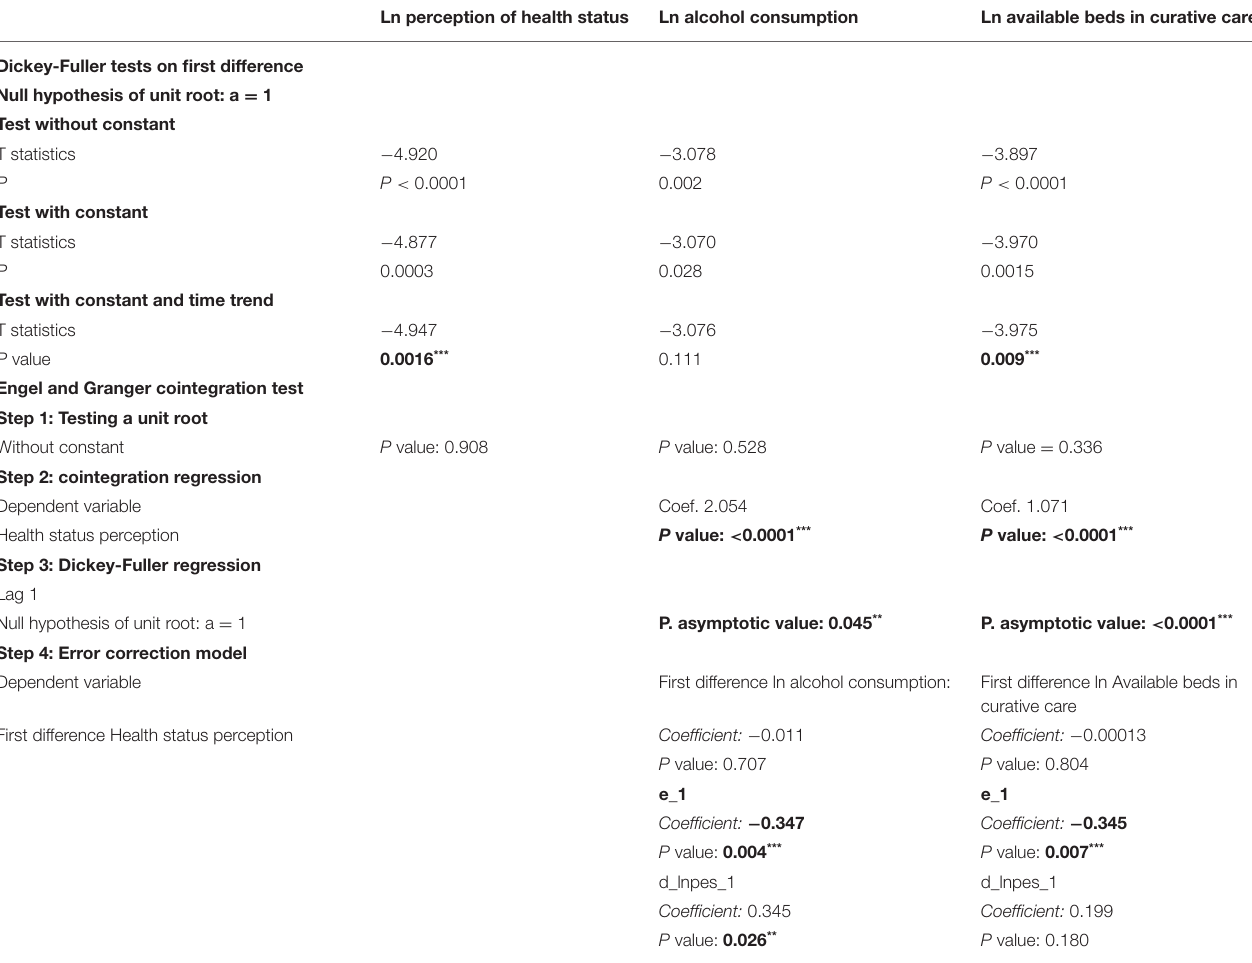
TABLE 4 | Engle Granger cointegration test between health status perception and alcohol consumption and bed occupancy rate in the period 1982–2018. Ln perception of health status Ln alcohol consumption Ln available beds in curative